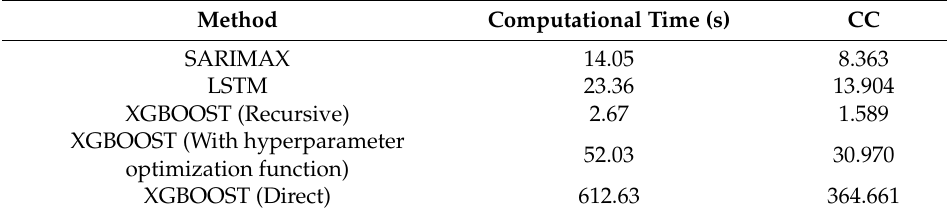
Figure 12. XGBOOST for 24-h ahead forecasting. Table 7. Results Computational complexity for multistep ahead forecasting. Table 6. Results & ranking of the performance metrics.